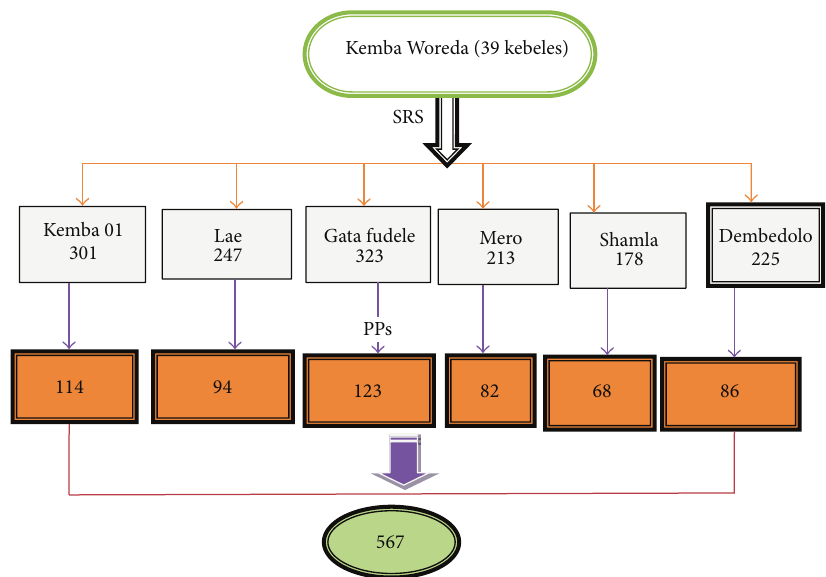
Figure 1: Schematic presentation of sampling procedure in Kemba Woreda, Southern Ethiopia,